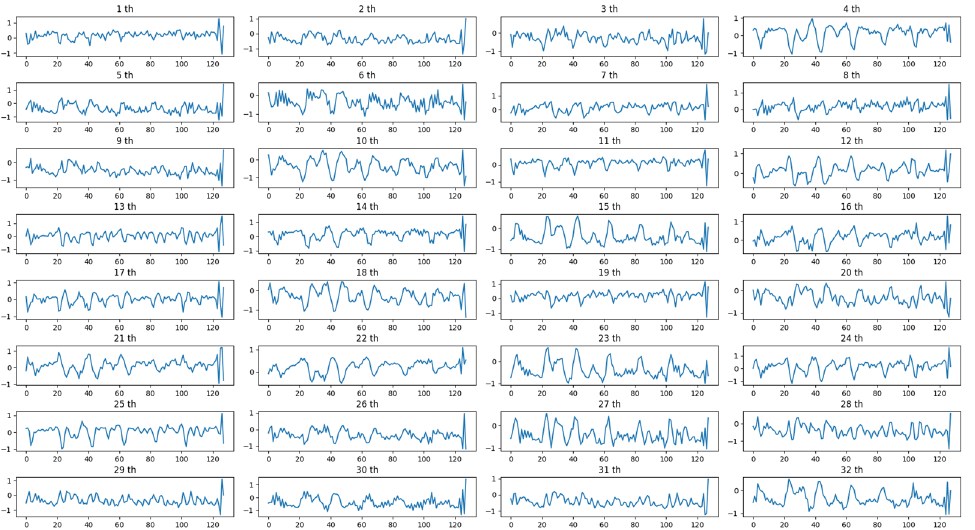
Figure 14. Feature vector output of the fifth convolution layer.